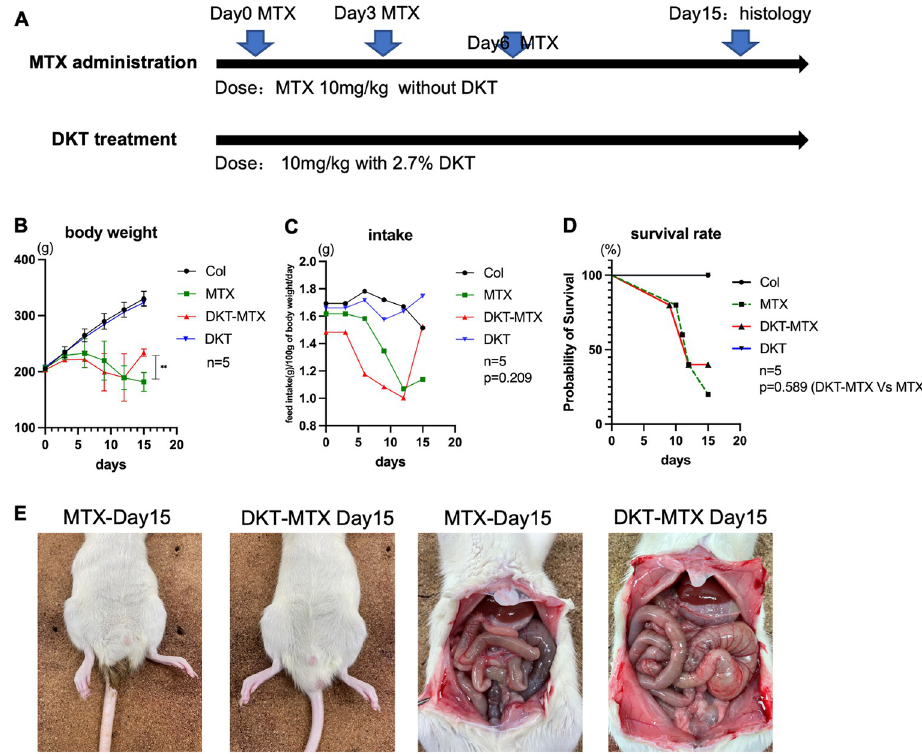
Fig 1. DKT enhanced the body weight recovery and ameliorated the symptoms of IM induced by MTX. (A) The experiment was performed according to the diagram. (B) The body weight of the rats was shown. Data are represented as mean ± standard error of the mean. One-way ANOWA test, followed by Tukey’s multiple comparison test for day15, ns > 0.05, ** p < 0.001. (C) The food intake of the rats was shown. Data are represented as meanonly, Student-t test for day 15 data, DKT-MTX Vs MTX, p = 0.209. (D) The survival rate of the rats in all groups was shown. Log-rank (Mantel-Cox) test, p value = 0.5890. (E) The rats in the DKT-MTX group had no obvious diarrhea, and the intestinal walls of the rats in the MTX group were